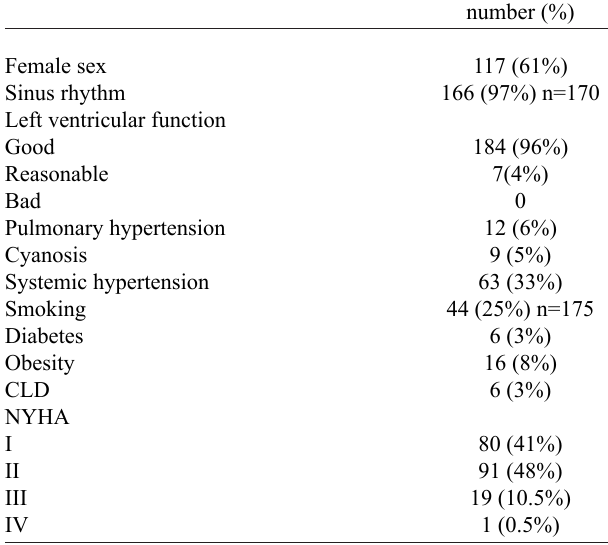
Table 1. Preoperative data in 191 patients operated on for